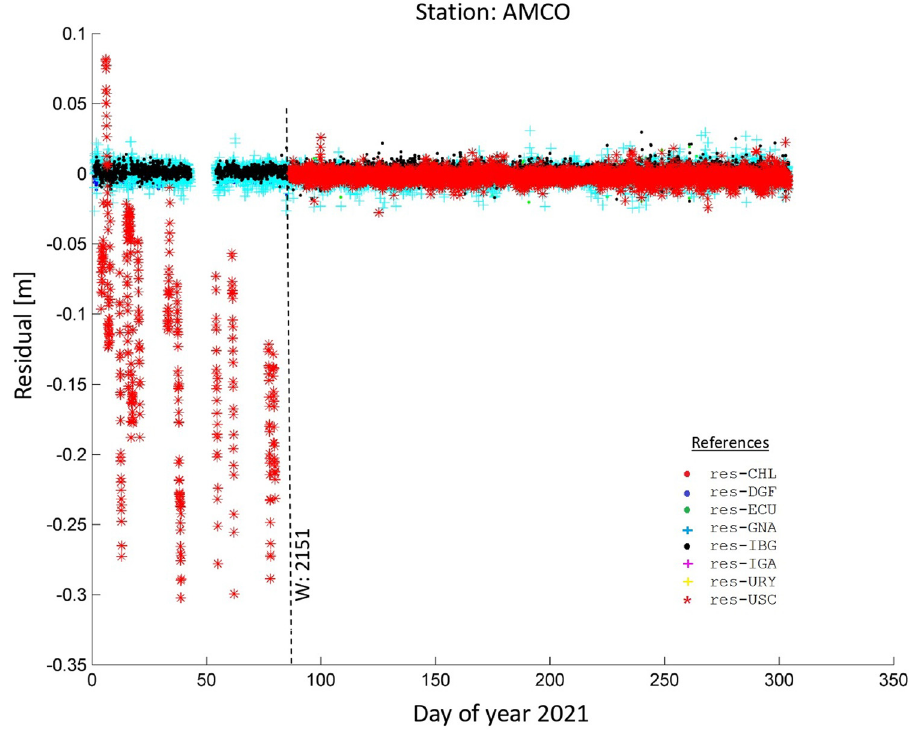
residuals in AMCO, SIRGAS - CON Station, day of year Figure 6: ZTD i tj